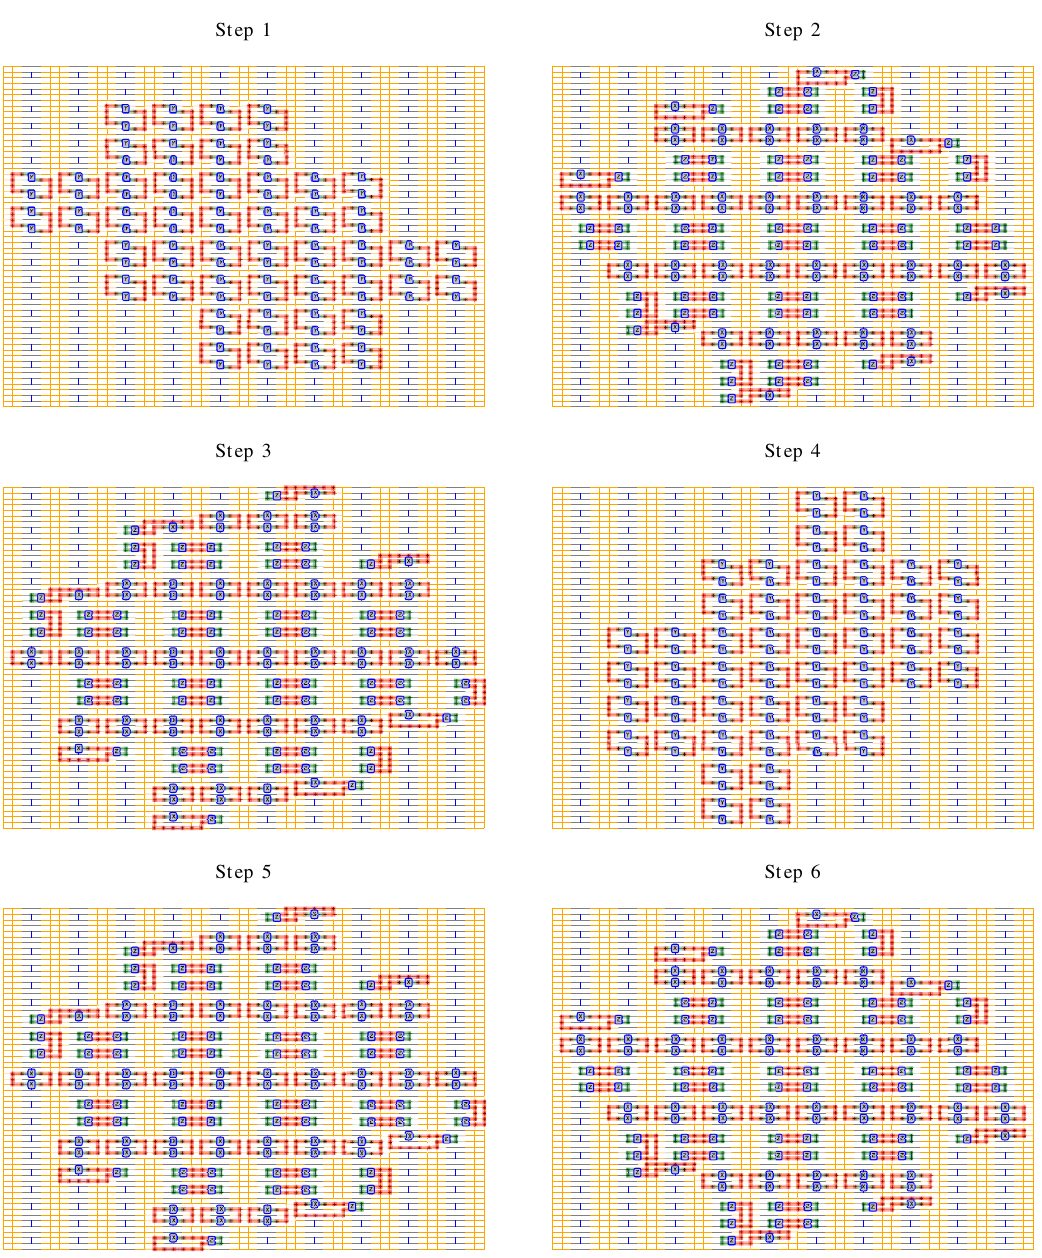
FIG. 10. The six-step measurement sequence for the planar 4.8.8 code patch shown in Fig. 2(b), as implemented in an array of tetron